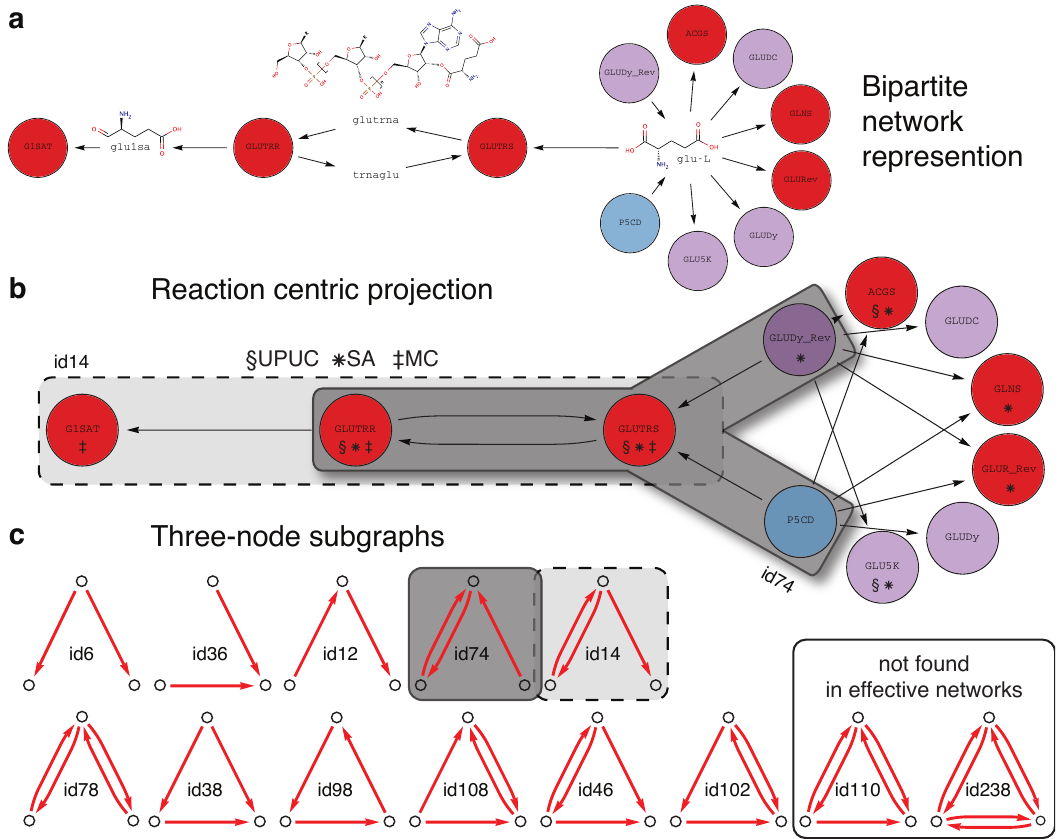
Bipartite network